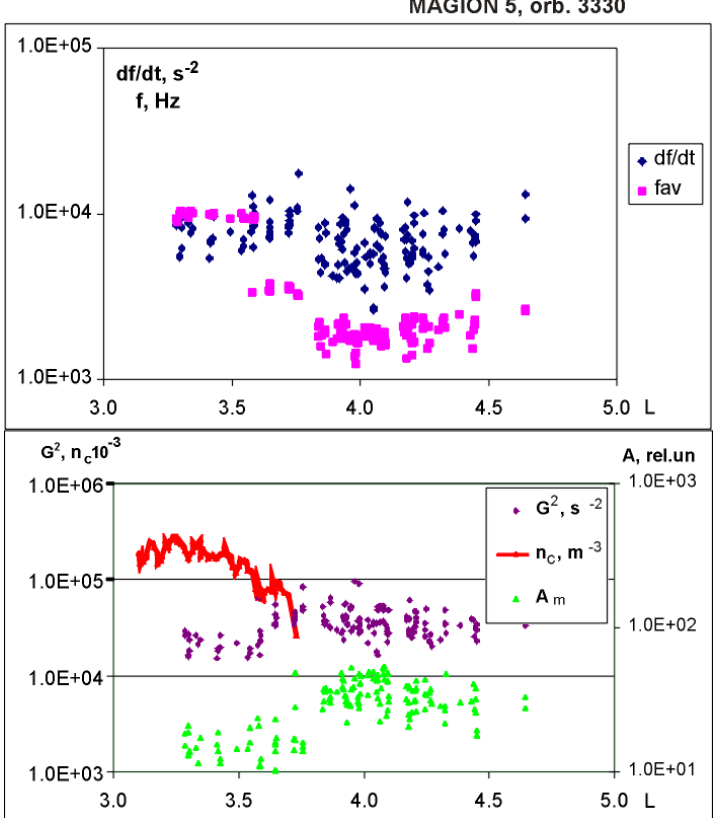
Fig. 5. Relationships of the frequency sweep rate df/dt and G 2 with chorus amplitudes on orbit 3330, MAGION-5. Top panel: The frequency sweep rate df/dt and the center frequency of the chorus elements f av depending on L-shell for orbit 3330, Magion 5. Bottom panel: The chorus amplitude, G 2 and the cold plasma density n c depending on L-shell for orbit 3330, Magion 5. Bottom panel shows a good correlation between G 2 and the chorus amplitudes in contrast to relationships between the frequency sweep rate df/dt and the chorus